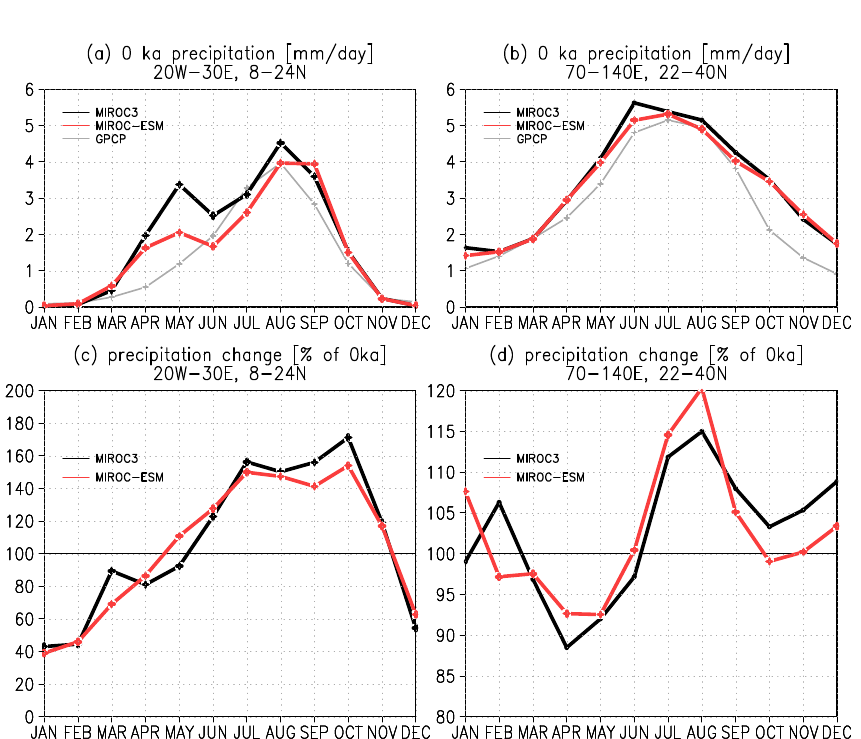
Fig. 1. 0ka seasonal precipitation for MIROC-ESM (red lines) and MIROC3 (black lines) for the (a) African area (20 ◦ W–30 ◦ E, 8–24 ◦ N) and (b) Asian area (70–140 ◦ E, 22–40 ◦ N). The GPCP observational data (Adler et al., 2003) are also plotted with thin grey lines. The change in 6–0ka (c, d) as a percentage of the 0ka precipitation amount